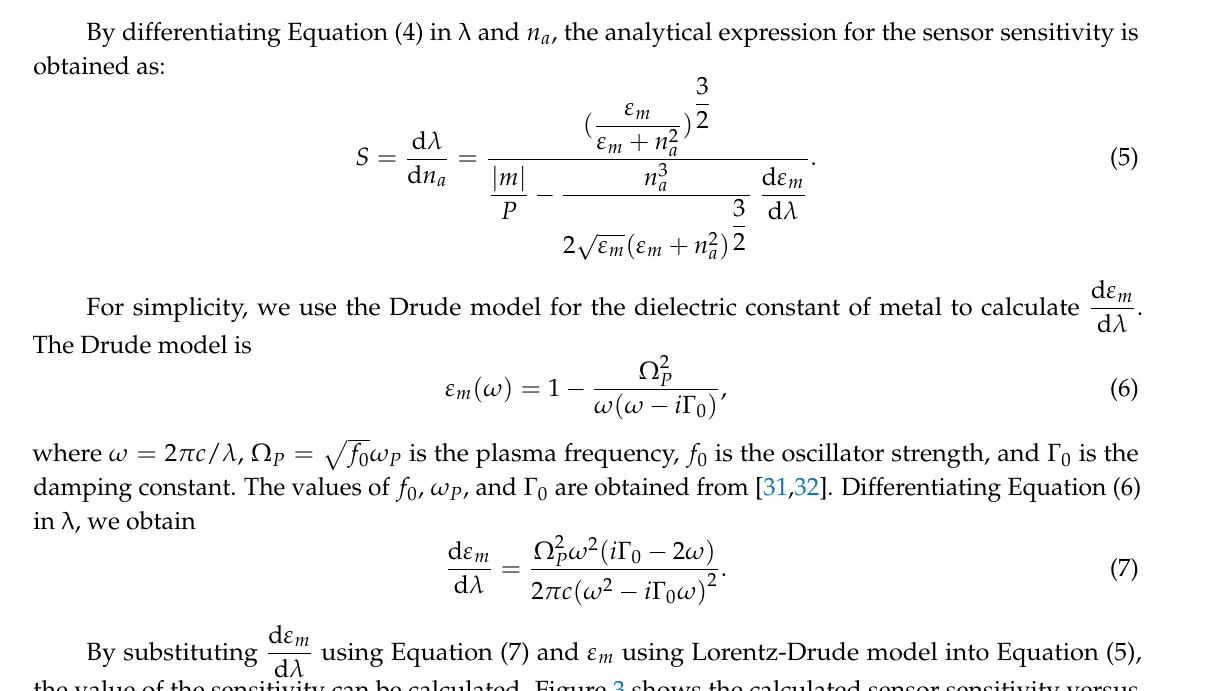
Figure 2. The angle of incidence as a function of the resonant wavelength for four different grating periods. The material of the grating is Au and 𝑛 (cid:3028) = 1.34 , 𝑚 = 1 .